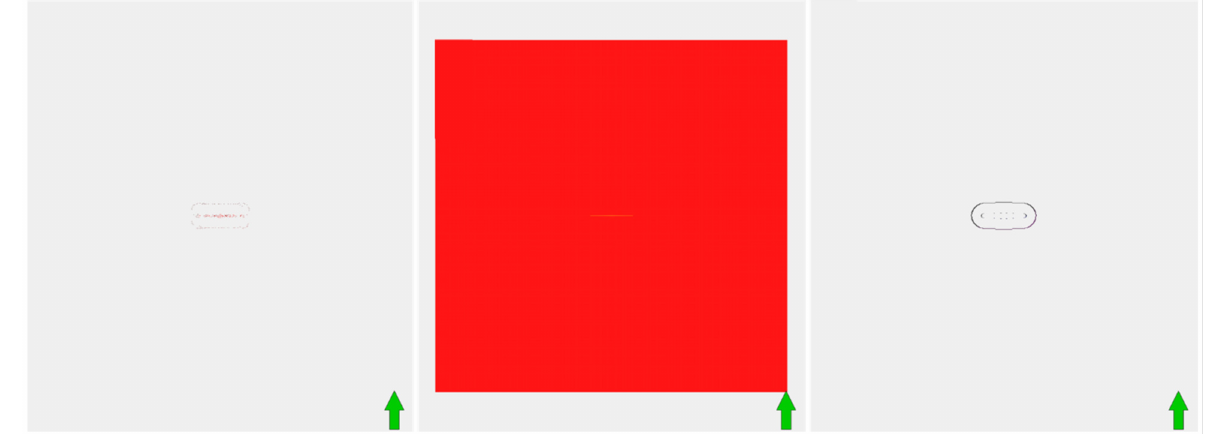
Figure 9. Early Time Linear Flow.